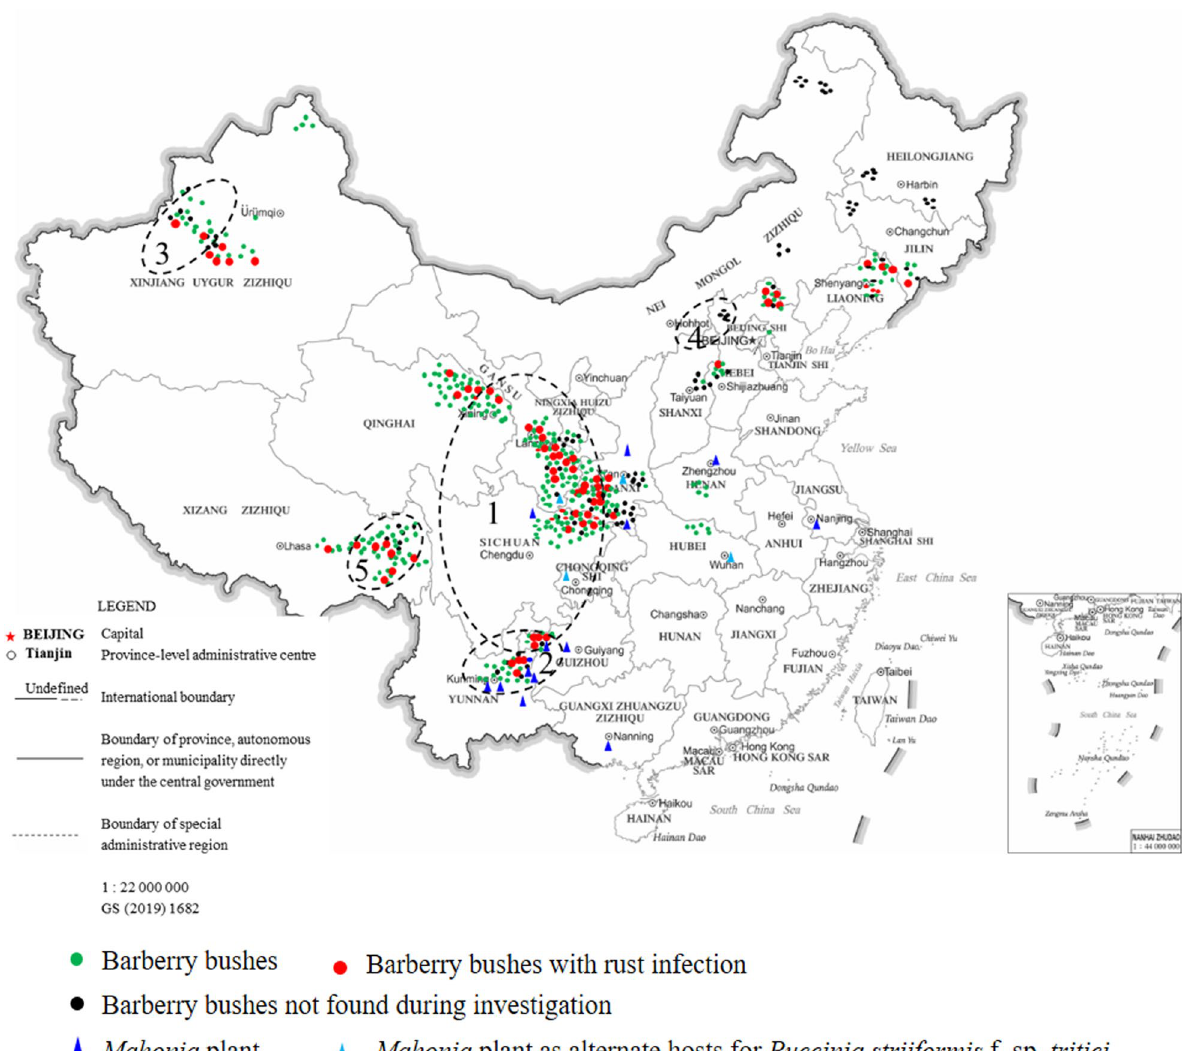
Fig. 7 The map showing extensive distribution of most of Chinese Berberis spp. and Mahonia spp. serving as alternate hosts for Puccinia striiformis f. sp. tritici in North-western area of oversummering areas, and a few Berberis spp. for P. graminis f. sp. tritici in Gansu, Shaanxi and Tibet in China based on data collections of field investigations during 2010–2020 (Zhao et al. 2013, 2015, 2016b; Wang et al. 2016; Du et al. 2019; Li et al. 2021; Zhuang et al. 2019; Cheng et al. 2022). Geographic outline of oversummering areas were redraw according to a review by Wan et al. (2007) and Tibet of oversummering area was added. 1 North-western area. 2 South-western area. 3 Xinjiang area. 4 Northern area. 5 Tibet area. Map resource: http:// bzdt. ch. mnr. gov. cn/. Data resource: Information on barberry data in Northeast China from Yuanyin Cao’s laboratory at Shenyang